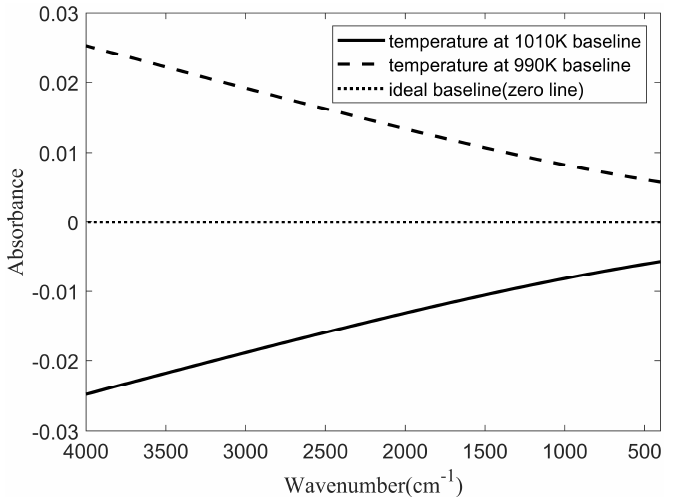
Figure 1. Ideal baseline and baseline at 990 K and 1000 K. As seen in Figure 1, when the temperature of the light source was increased by 10 K, the baseline was lower than the ideal baseline, and the deviation from the ideal baseline in the high wavenumber region was greater than that in the low-wavenumber